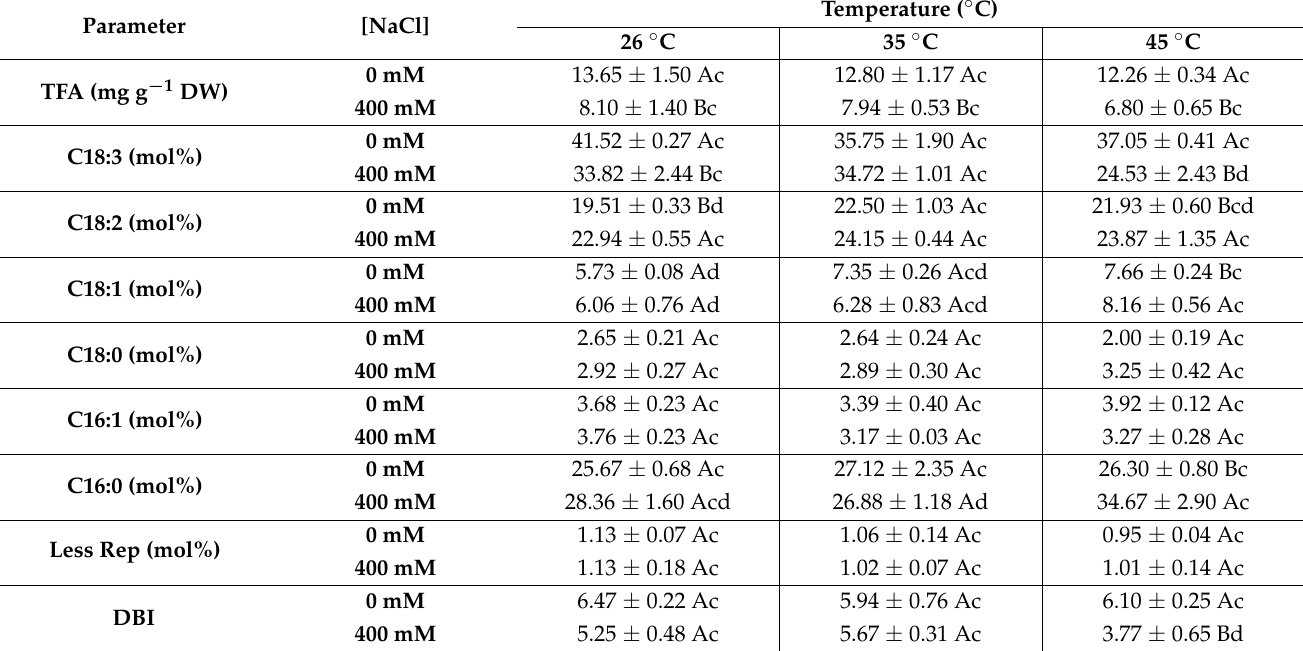
Table 3. Total fatty acids (TFA, mg g − 1 DW), fatty acid composition (mol%) and unsaturation (DBI) of C. glauca branchlets under the single and combined exposure to salt (0 and 400 mM NaCl) and temperature (26, 35 and 45 ◦ C) conditions. C18:3-linolenic acid. C18:2-linoleic acid. C16:0-palmitic acid. C18:1-oleic acid. C18:0-stearic acid. C16:1-hexadecenoic acid and less representative (Less Rep) fatty acids (i.e., the sum of less abundant FAs, namely C15:0–pentadecanoic